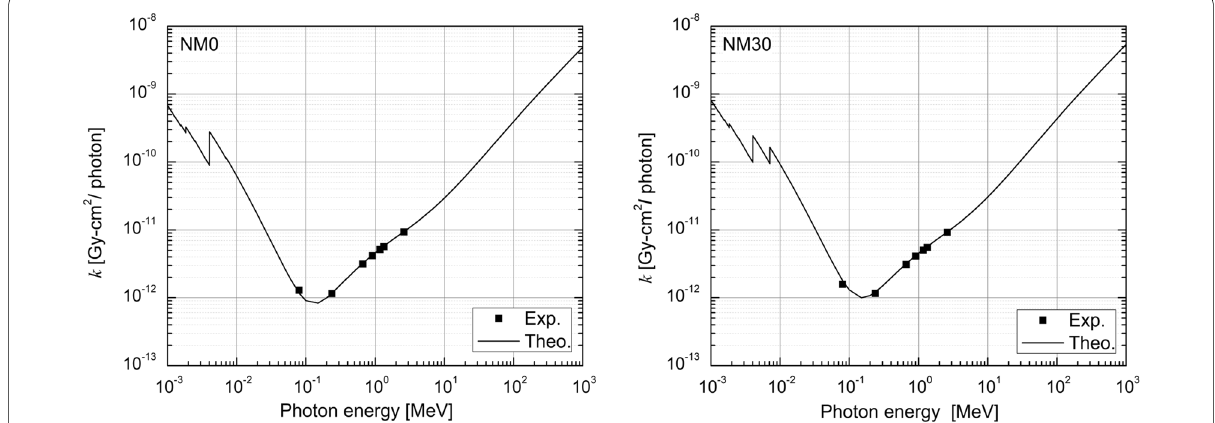
Fig. 14 Kerma coefficients for NM0 (left) and NM30 (right) cement